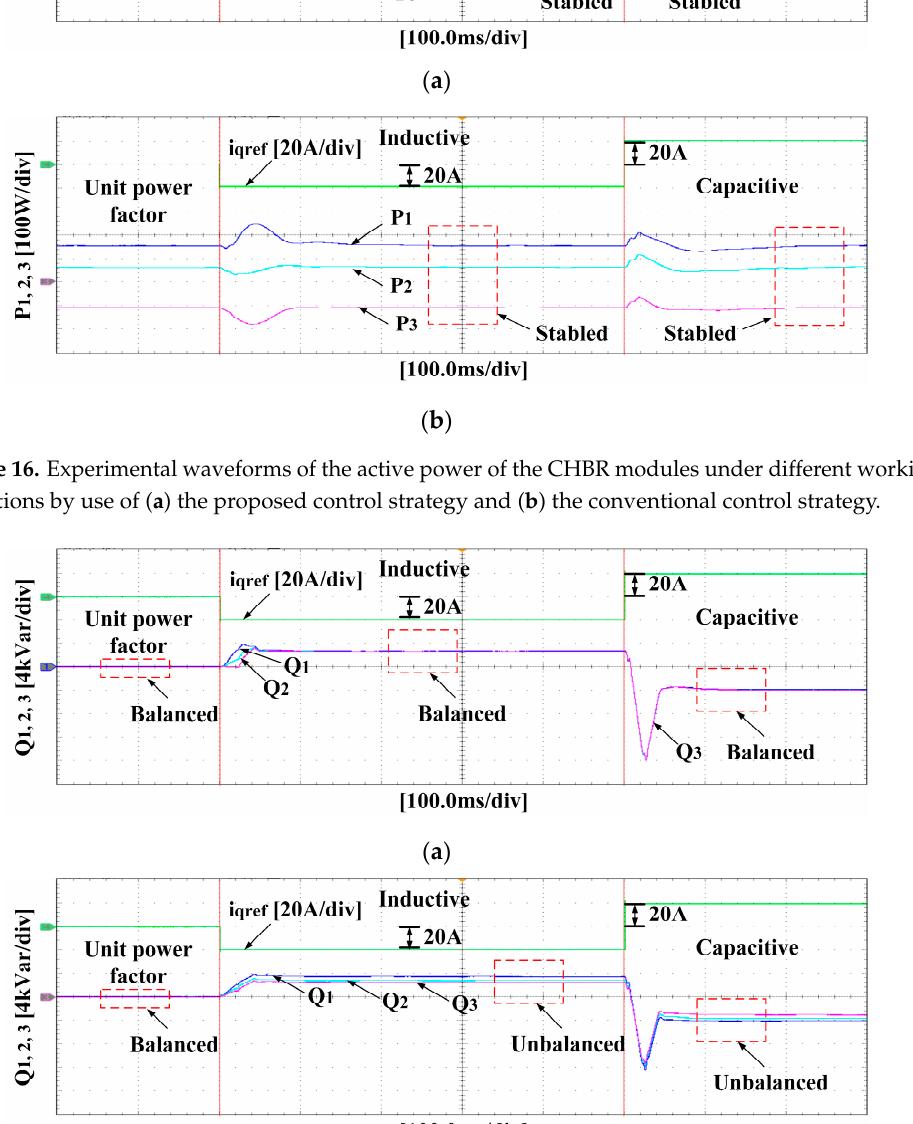
Figure 17. Experimental waveforms of the reactive power of the CHBR modules under different working conditions by use of ( a ) the proposed control strategy and ( b ) the conventional control strat- egy.